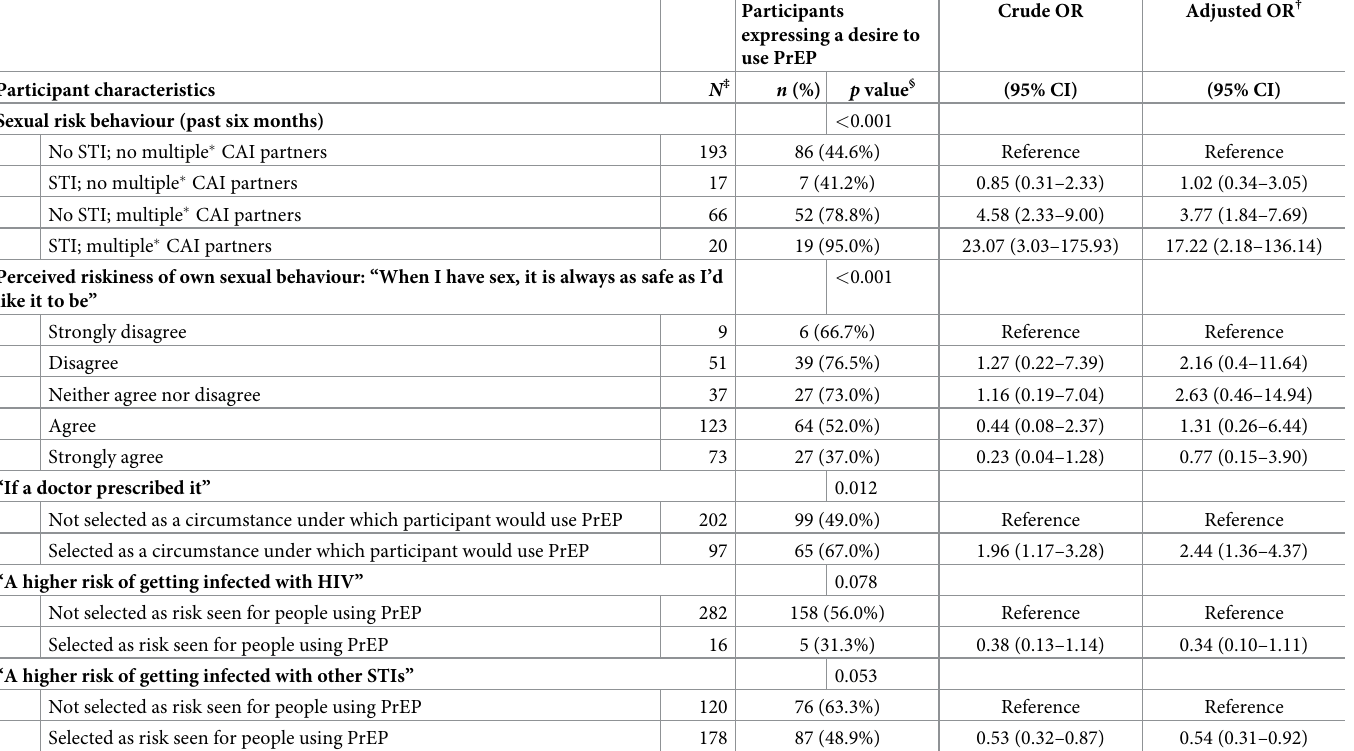
Participants Crude OR Adjusted OR † expressing a desire to use PrEP